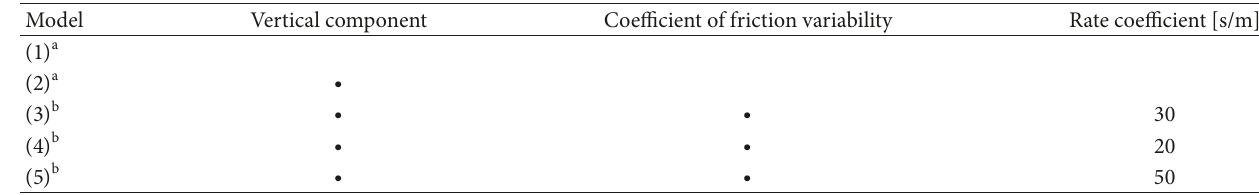
Table 8: Summary of seismic isolated bridge model parameters.